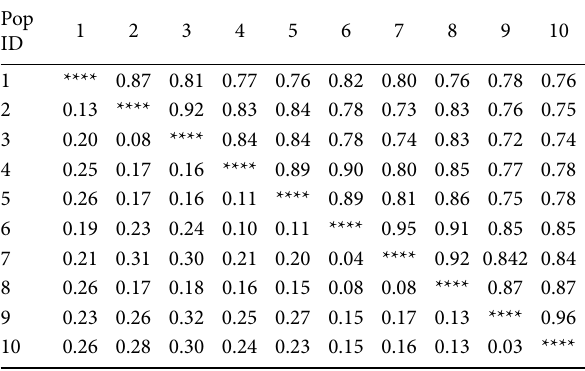
Table 5. Nei genetic distance versus genetic identity of P. afar popu- lations. Nei’s genetic identity (above diagonal) and genetic distance (below diagonal).